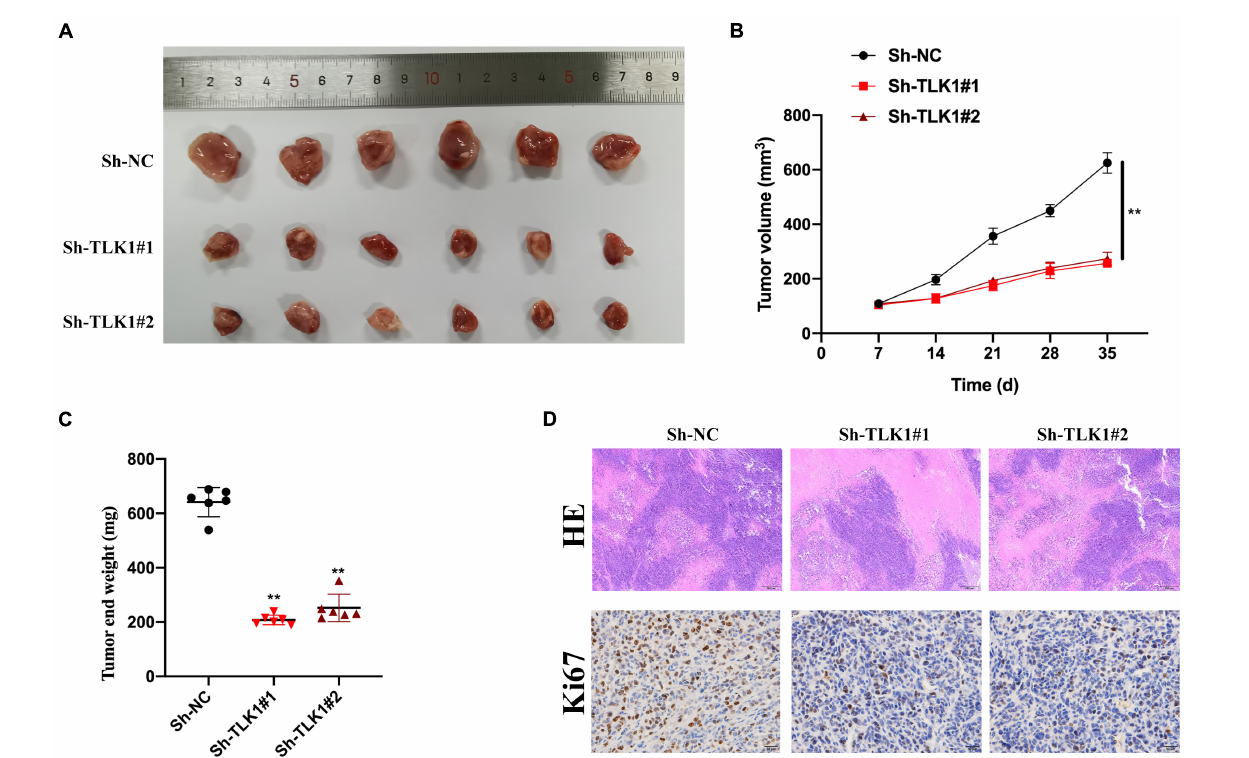
FIGURE 3 | Downregulated circTLK1 inhibits glioma cell growth in vivo . Mice were separated into three groups ( n = 6) and then subcutaneously injected with U251 (10 6 per mouse) cells preinfected with Sh-NC, Sh-circTLK1#1, and Sh-circTLK1#2. (A) Representative image of subcutaneously incubated tumors ( n = 6). (B) Tumor volumes were recorded every 3 days, and statistical results are presented. (C) Tumor end weights were recorded, and comparative statistics are shown. (D) Tumor histology was assessed using H&E staining (scale bar, 200 µ m), and the proliferation marker Ki67 was detected using IHC staining (scale bar, 50 µ m). **p <